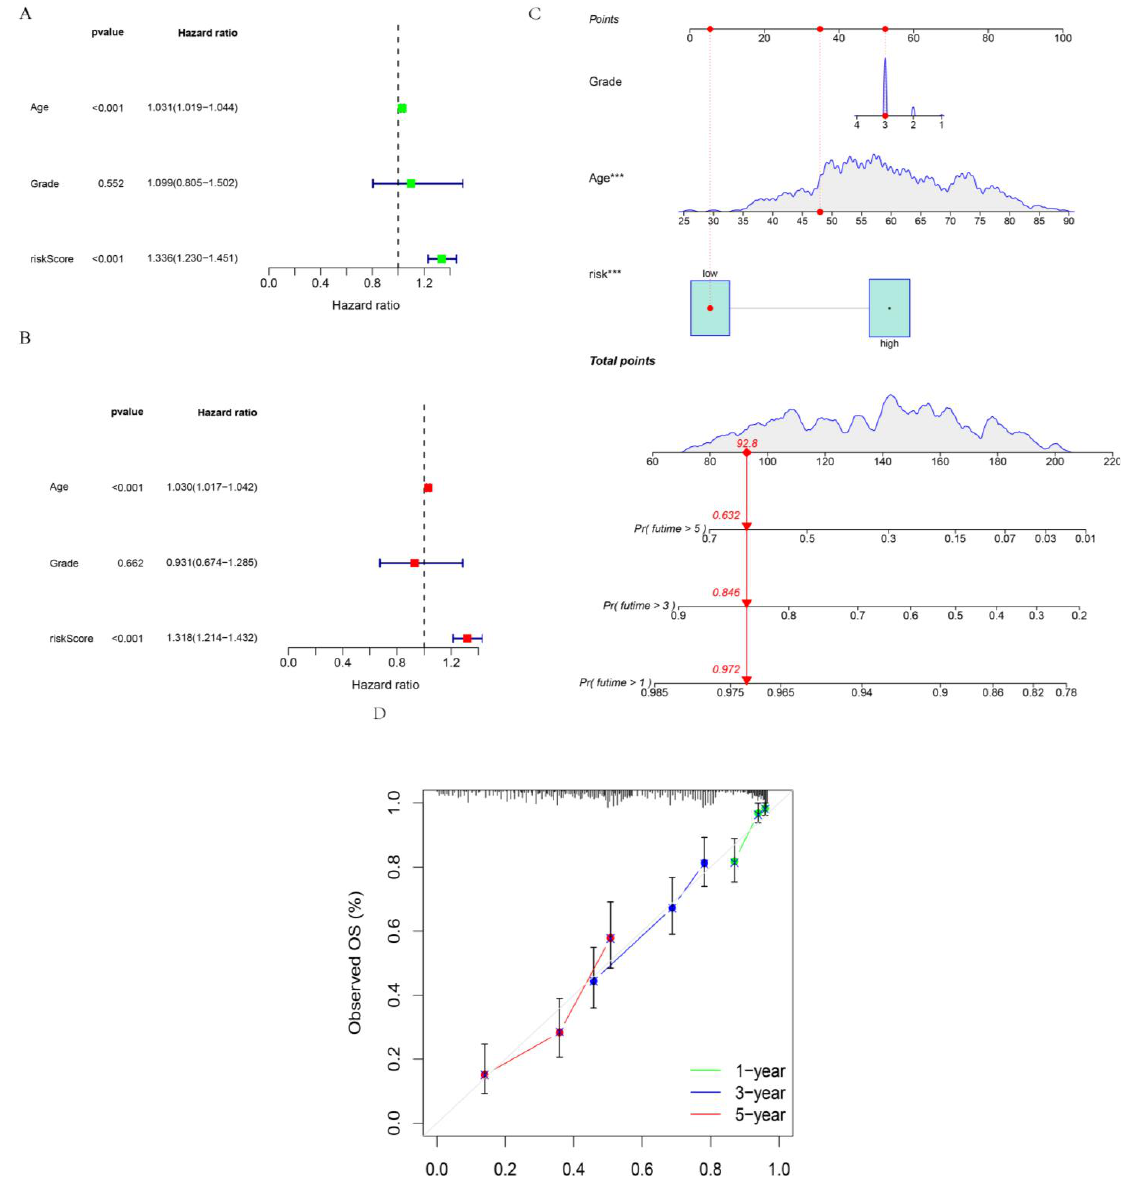
Figure 7. Construction of nomogram model. ( A ) Univariate Cox regression analyses were performed using the risk score and other clinicopathological variables. The green color denotes the point estimates of hazard ratio (HR) for each variable. ( B ) Multivariate Cox regression analyses were performed using the risk score and other clinicopathological variables. The red color denotes the point estimates of hazard ratio (HR) for each variable. ( C ) The nomogram model was constructed based on the risk score and other clinicopathological variables. The upper part of the diagram uses red color to indicate the score values associated with the variable, while the lower part shows red color to represent the survival rates for 1, 3, and 5 years that correspond to a total score of 92.8. ( D ) The nomogram’s accuracy was assessed using calibration curves. The green color represents the calibration curve of 1 year. The blue color represents the calibration curve of 3 years. The red color represents the calibration curve of 5 years (*** p <